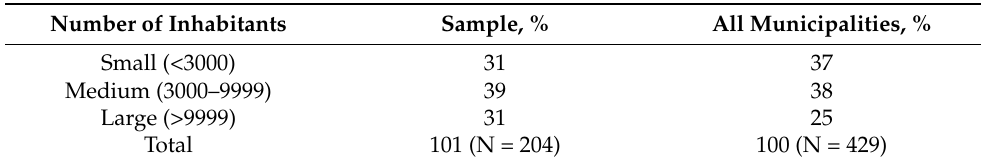
Table 1. Inhabitants in Norwegian municipalities. Sample and the country. Percent. Number of